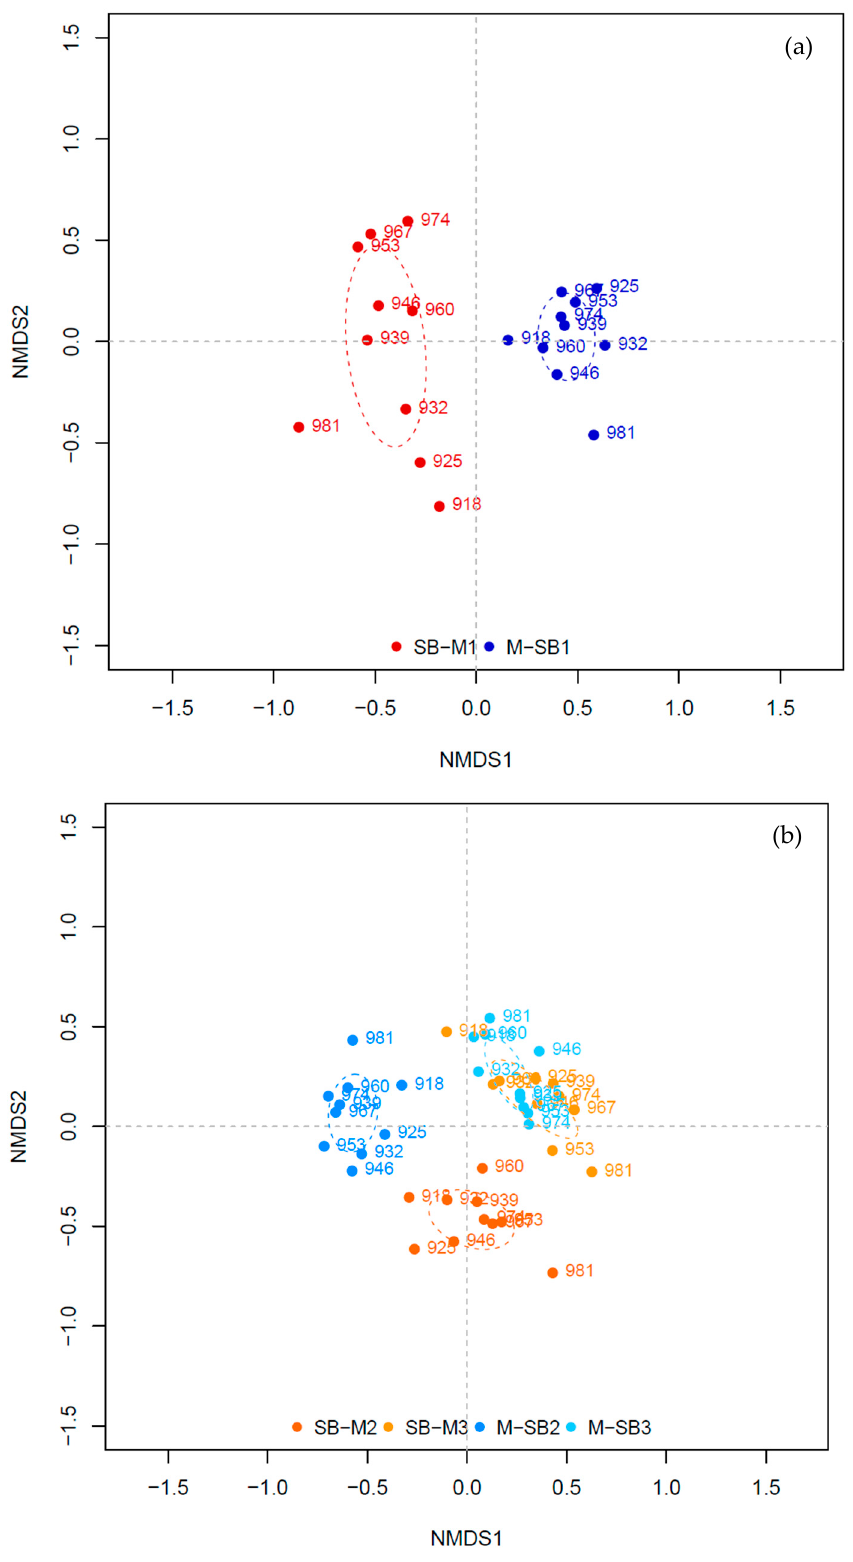
Figure 4. Non-metric dimensional scaling (NMDS) of the reactors with low TAN ( a ), stress = 0.15 and with high TAN ( b ), stress = 0.20.